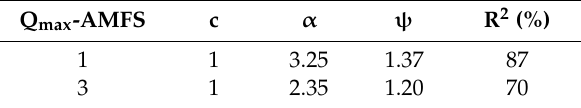
Table 2. Coe ffi cients of non-linear interpolation from Figure